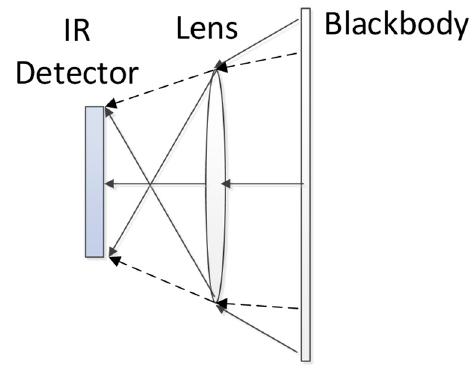
Figure 2. Schematic diagram of the radiometric calibration.